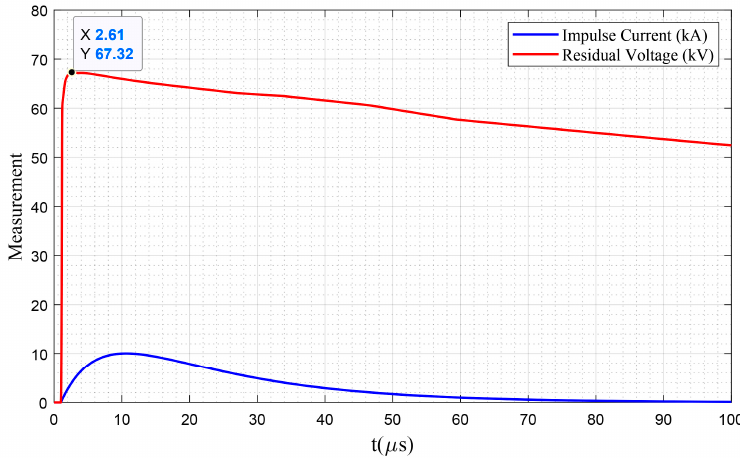
Figure 10. Residual voltage under a 10 kA current impulse (8/20µs).